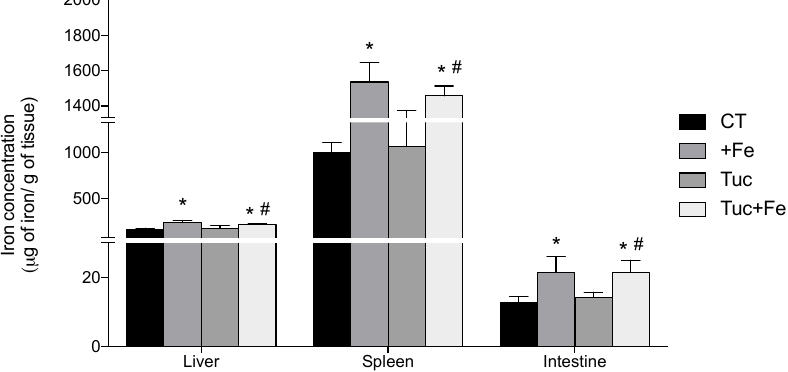
Figure 1. Effect of iron and/or tucum-do-cerrado intake in total iron concentration in the liver, spleen and intestine of adult rats treated for 12 weeks. Data correspond to average ± standard deviation ( n = 6). * Statistical differences compared to CT group ( p < 0.05). # Statistical differences compared to Tuc group ( p < 0.05).